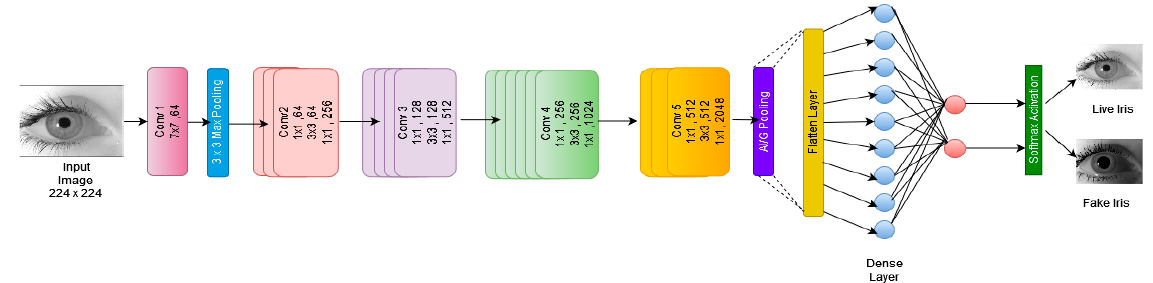
Figure 4. The ResNet 50 architecture, designed for iris liveness detection.